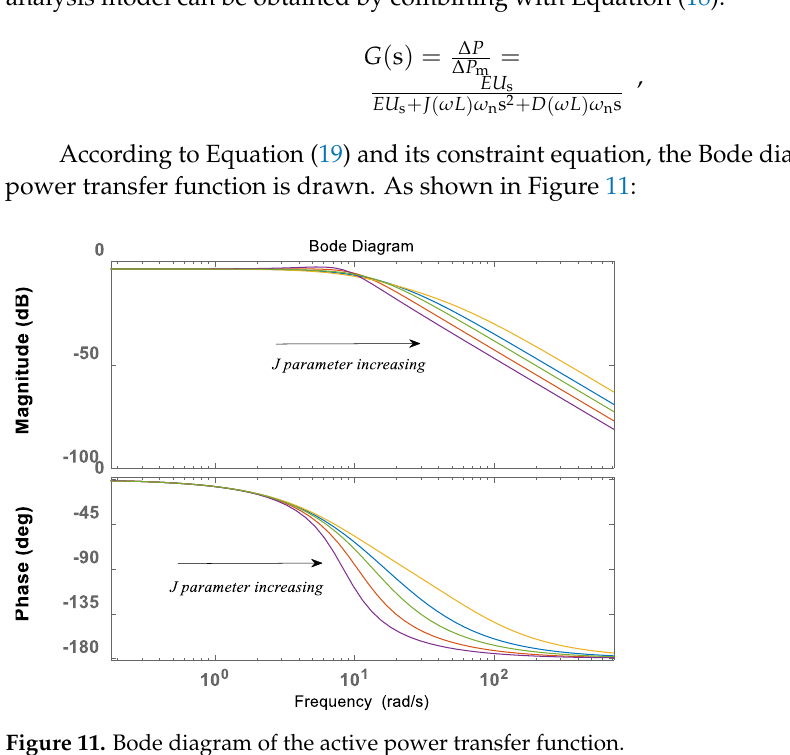
Figure 12. Block diagram of double closed-loop control.